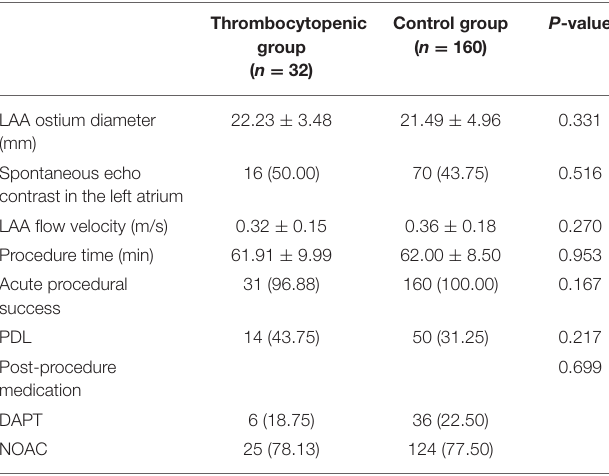
TABLE 2 | Procedural